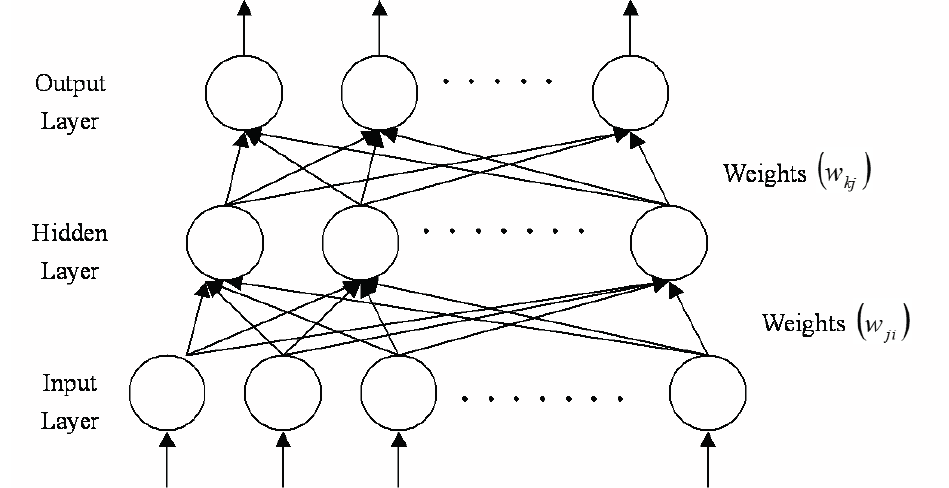
Figure 2. The architecture of a three layer backpropagation neural network .